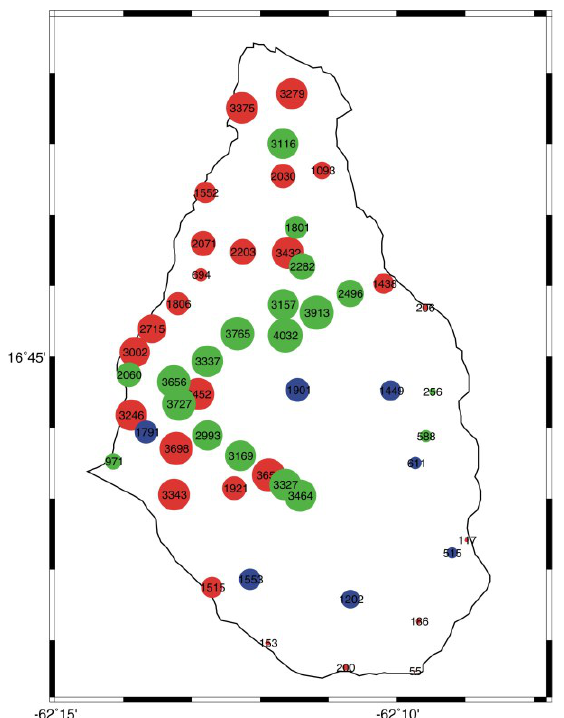
Figure A2. Number of observations used in the seismic tomography inversion shown for each on-shore seismometer. Red dots indicate Reftek seismometers. Green dots indicate Texan miniature seismic recorders and blue dots indicate seismometers which are part of the permanent monitoring network of the Montserrat Volcano Observatory.